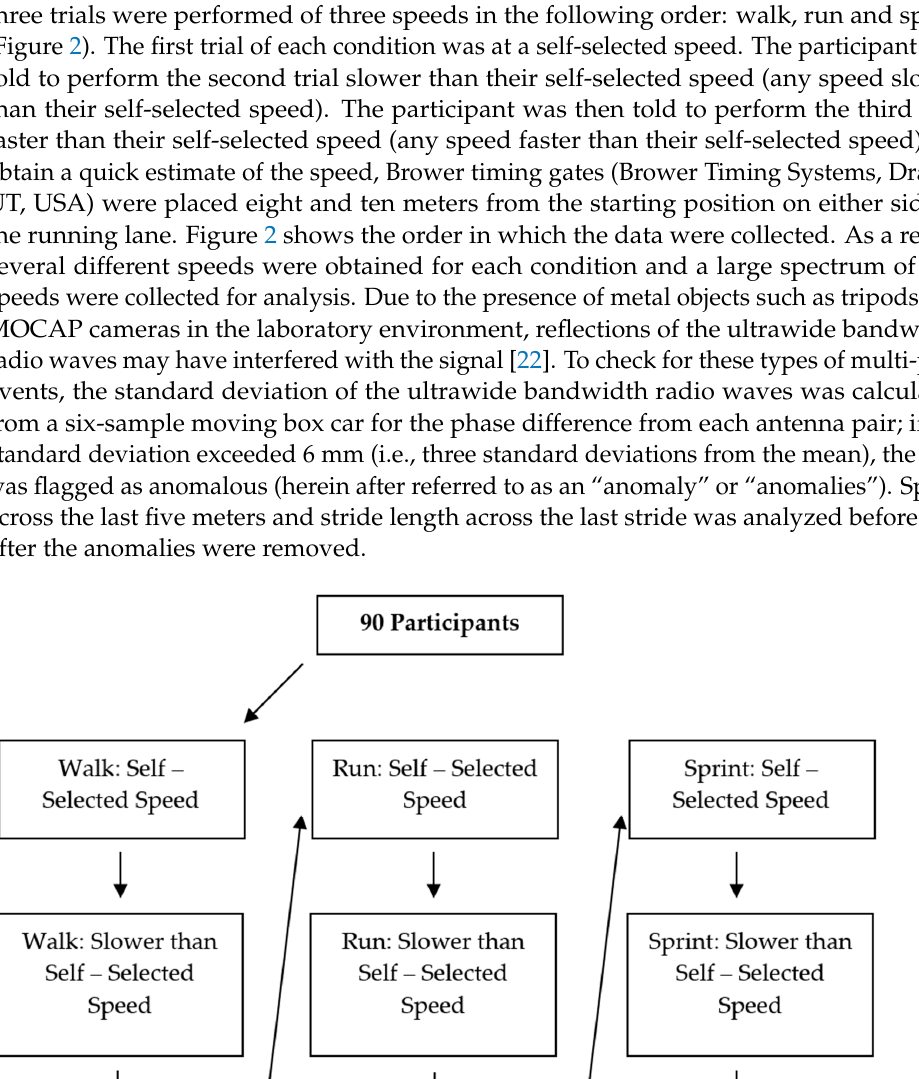
Figure 2. A flowchart highlighting the order of the protocol performed. Speed from the LPS was obtained by finding the change in the x -axis position across the last five meters per unit time. Stride segmentation from the LPS was obtained by find- ing peaks in the superior-inferior direction of the IMU data from the accelerometer and deeming them as heel strikes [23]. Stride length was calculated as the difference in position obtained from the LPS.